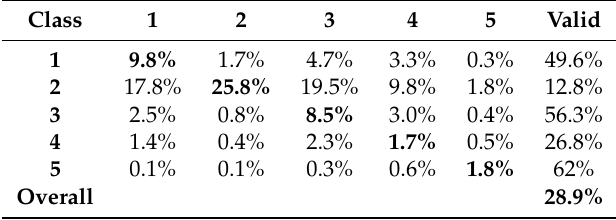
Table 4. Results from the test part of the dataset from the CNN for vehicle classification. Final results for each class on the main diagonal in confusion matrix (highlighted as bold) are shown.